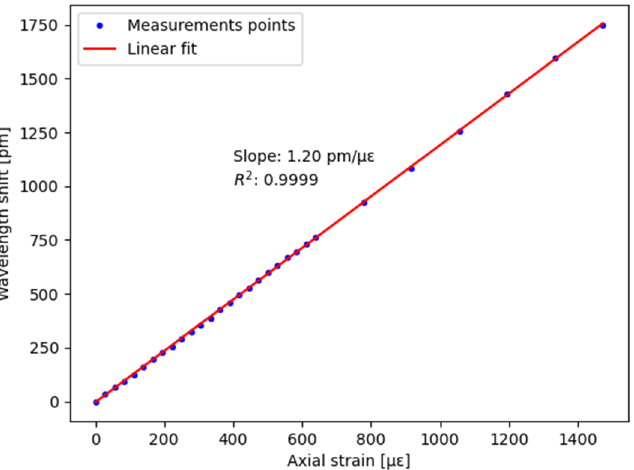
Figure 3. Calibration test of the smart interrogator for axial strain